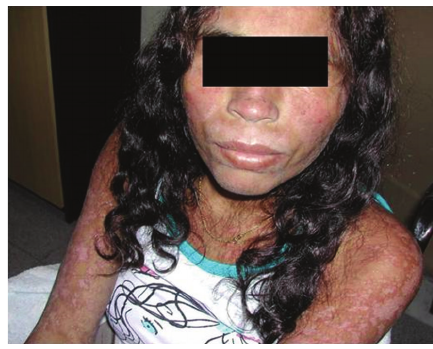
Figure 3: Ulcerated lesion with raised borders and sanguinary erythematous background in inferior member.